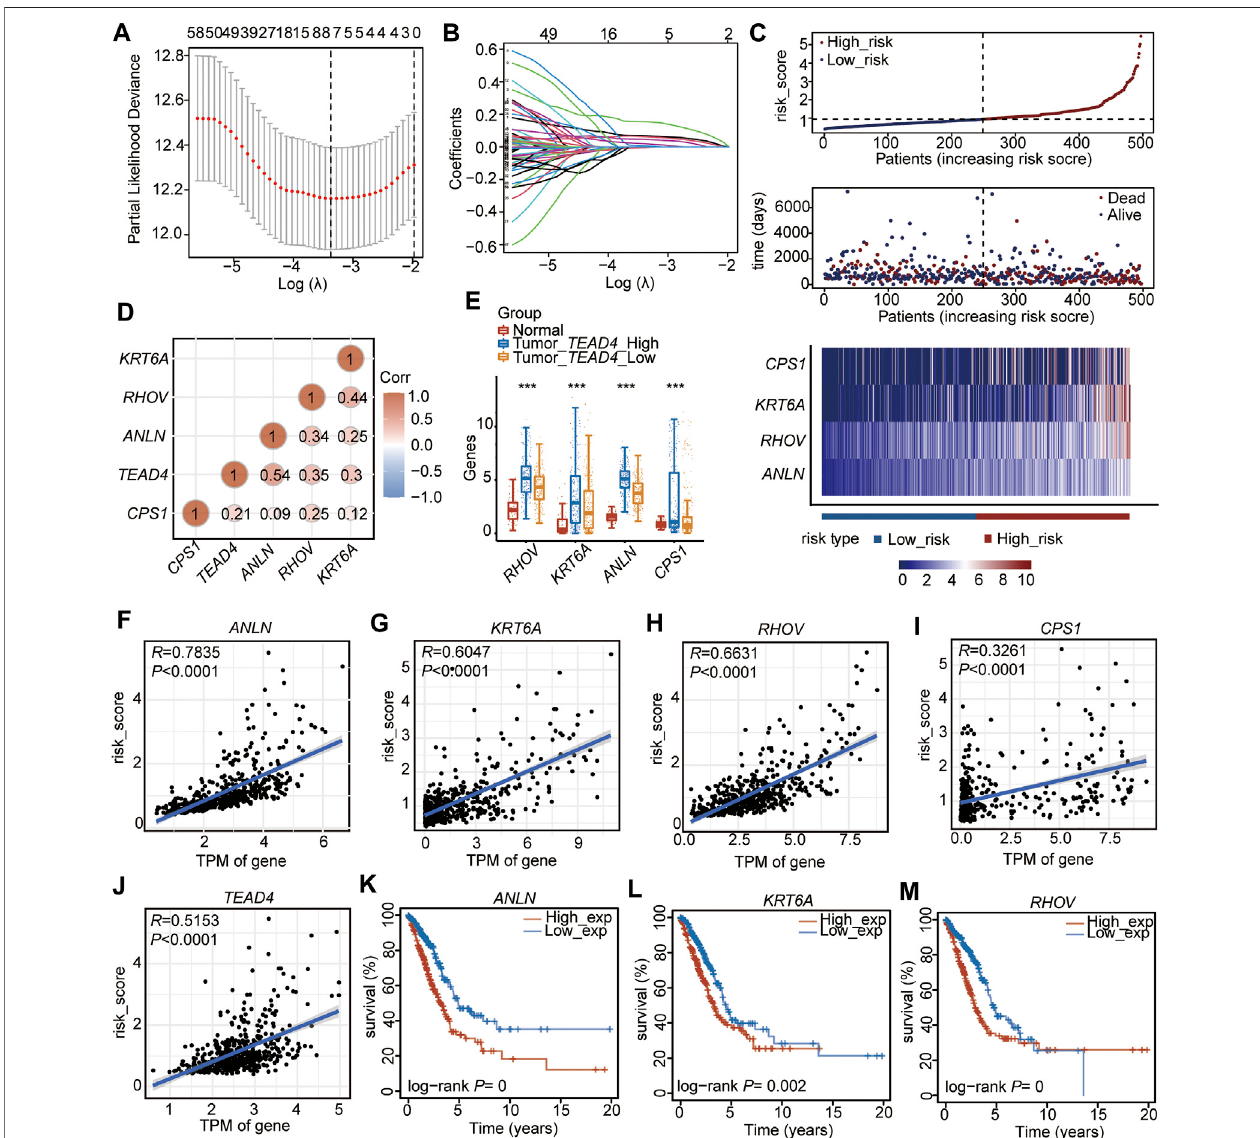
FIGURE 3 | Establishment of the prognostic signature based on the high TEAD4 expression in TCGA-LUAD. (A) Stepwise Cox proportional risk regression model to screen the prognostic genes. (B) LASSO coef fi cient spectrum of prognostic gene screening. (C) Risk score distribution, survival status of patients, and heatmap of prognostic gene distribution in the training cohort. (D) Correlation analysis of prognostic genes and TEAD4 in LUAD. The circle size represents signi fi cance. (E) TPM of the four prognostic genes in LUAD samples with TEAD4- high expressions, LUAD samples with TEAD4- low expressions, and the corresponding adjacent normal samples. The statistical signi fi cance was calculated via the Wilcoxon rank-sum test, *** p < 0.001. (F – J) Correlation analysis between the prognostic genes and risk score. (K – M) Relationship between ANLN (K) , KRT6A (L) , and RHOV (M) expressions and OS in